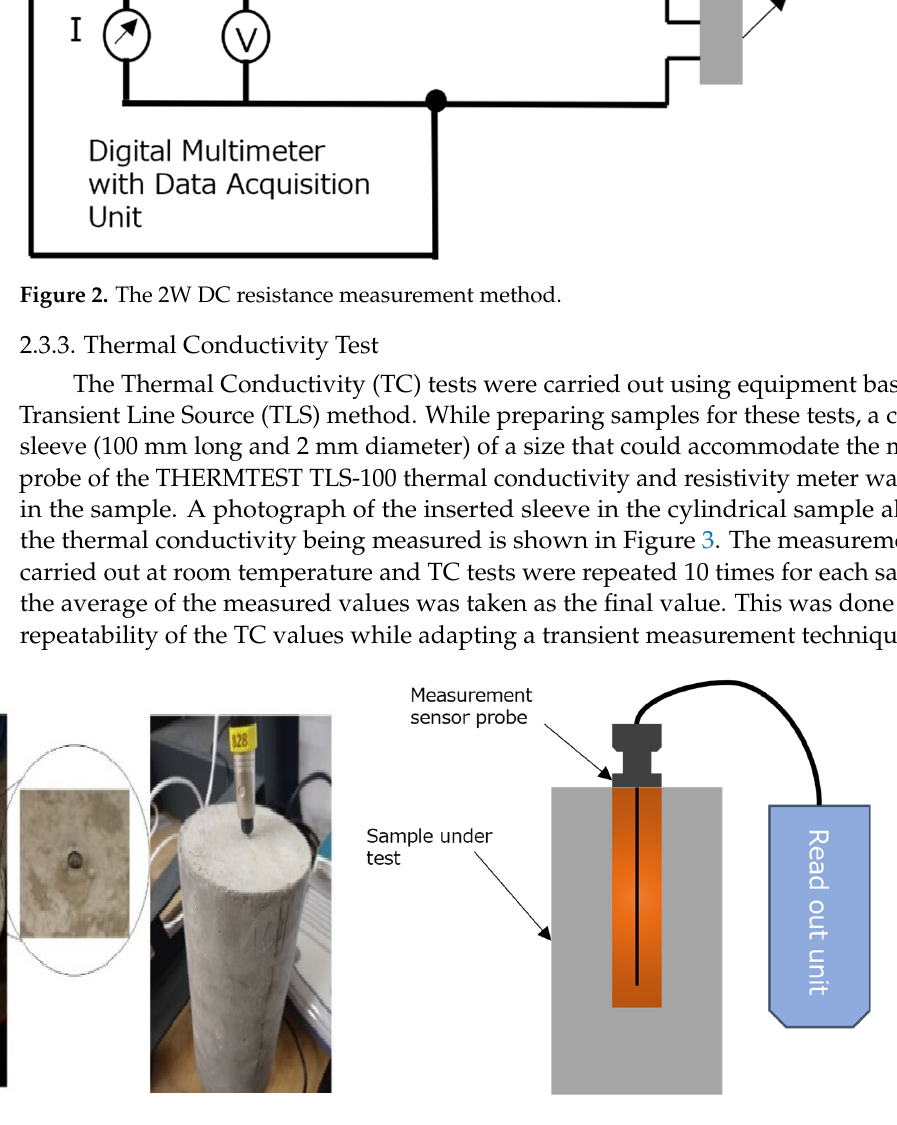
Figure 3. Cylindrical sample with sleeve used for thermal conductivity tests.